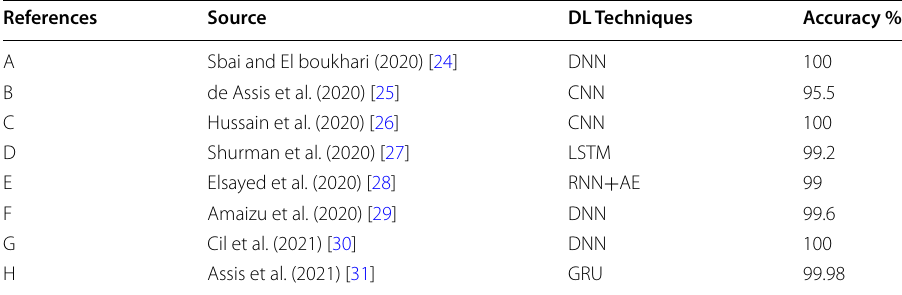
Table 2 Accuracy of deep learning approaches for DoS attacks detection on CICDDoS2019